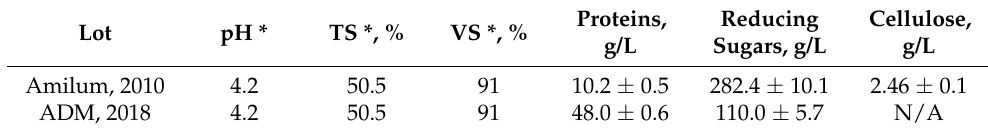
Proteins, Reducing Cellulose, g/L Sugars, g/L g/L